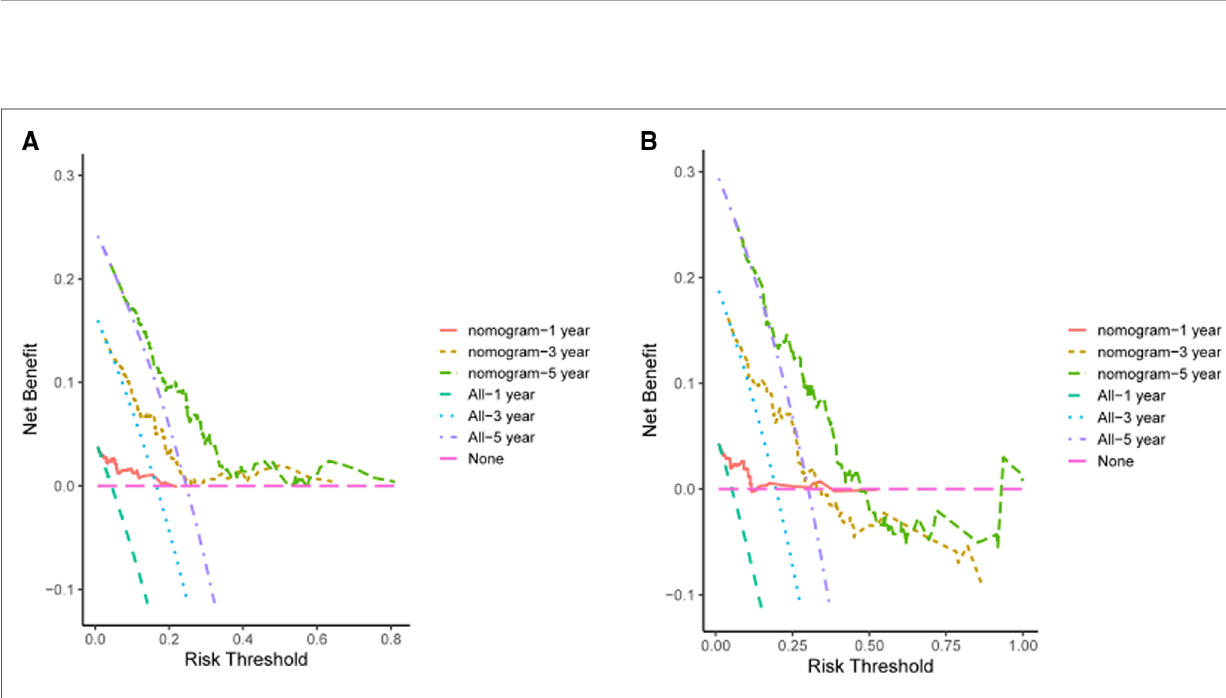
FIGURE 6 Calibration curves of the LAR-nomogram for 1-year, 3- years and 5- years survival prediction in the training and validation cohort. ( A ). training cohort. ( B ). validation cohort.